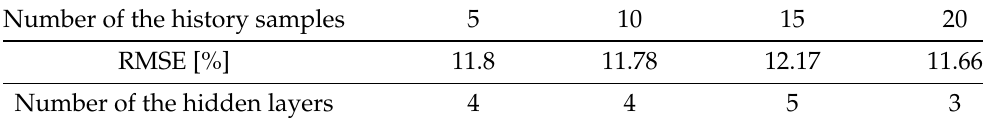
Table 5. Calculated the smallest RMSE for the selected numbers of nodes in hidden layers.